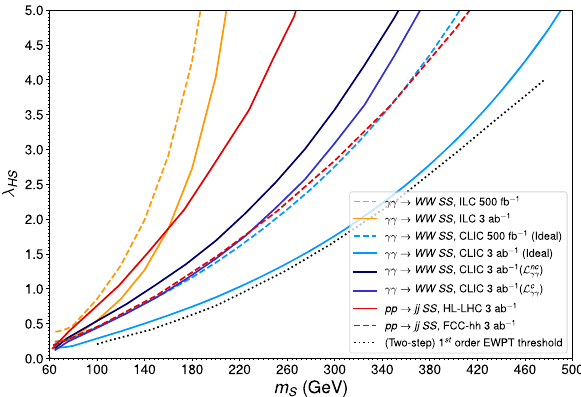
Fig. 8 2 σ sensitivity in the ( λ HS , m S ) plane of the singlet Higgs portal √ s = model, fora γγ colliderbasedonan e + e − center-of-mass energy √ s = 3 TeV (“CLIC”). Different curves correspond 1 TeV (“ILC”) and to:ILC500fb − 1 withideal L γγ (dashed-yellow),ILC3ab − 1 withideal L γγ (solid-yellow), CLIC 500 fb − 1 with ideal L γγ (dashed-light-blue), CLIC 3 ab − 1 with ideal L γγ (solid-light-blue), CLIC 3 ab − 1 with L nc γγ (solid-black) and CLIC 3 ab − 1 with L c γγ (solid-dark-blue). We also show the 2 σ sensitivity of HL-LHC (solid-red) and FCC-hh (dashed- red)viatheprocess pp → jj SS .Thedotted-blacklineshowsthelower threshold for a two-step 1 st order EW phase transition, as obtained from